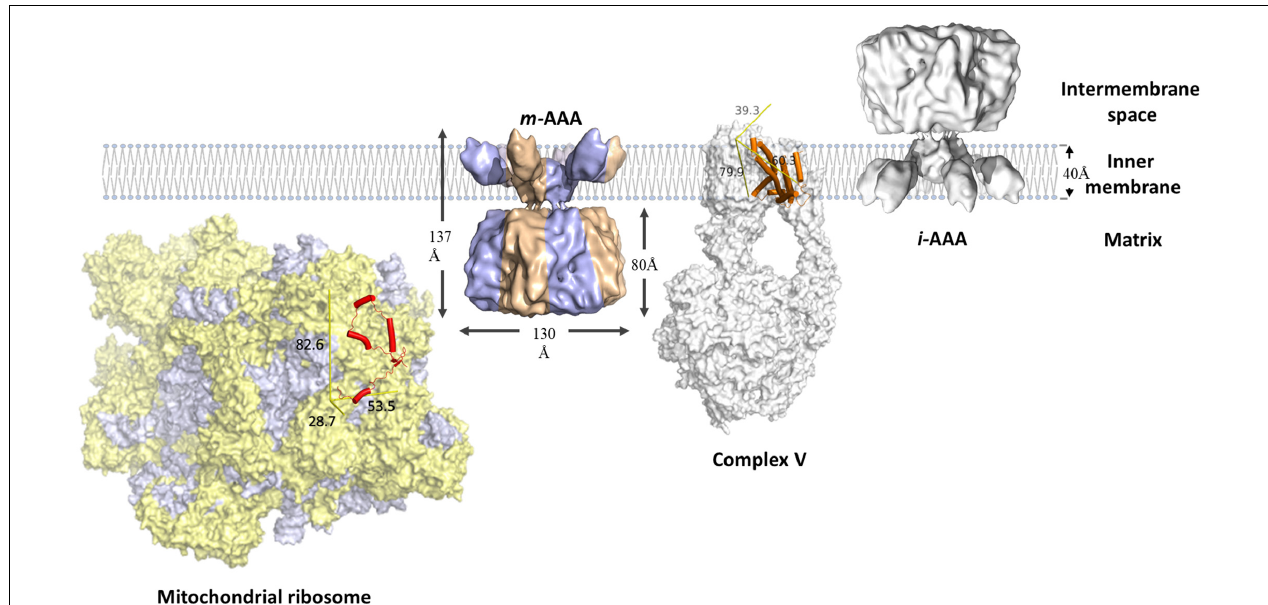
FIGURE 4 | Schematic representation of mitochondrial FtsH complexes. The i -AAA is a homocomplex facing the intermembrane space, the m -AAA is a heterocomplex (blue and bronze) facing the mitochondrial matrix. Both complexes are modeled using the cryo-EM structure of yeast m -AAA (Lee et al., 2011). The unassembled F o a (orange cylinders) subunit of respiratory complex V (PDB: 6CP6) is a membrane protein substrate of m -AAA. MrpL32 (red cylinders) is a subunit of the mitochondrial ribosome (PDB: 5MRC), which consists of protein (yellow) and RNA (purple-gray) components. MrpL32 is a soluble substrate that requires post-translational modification by m -AAA. The proteins are scaled using the membrane width as reference. The yellow reference rulers represent the dimension (unit: Å) of the Inertia Axis Aligned Bounding Box (IAAB) for the respective protein, which are calculated by Guardado-Calvo’s Python scripts for pymol